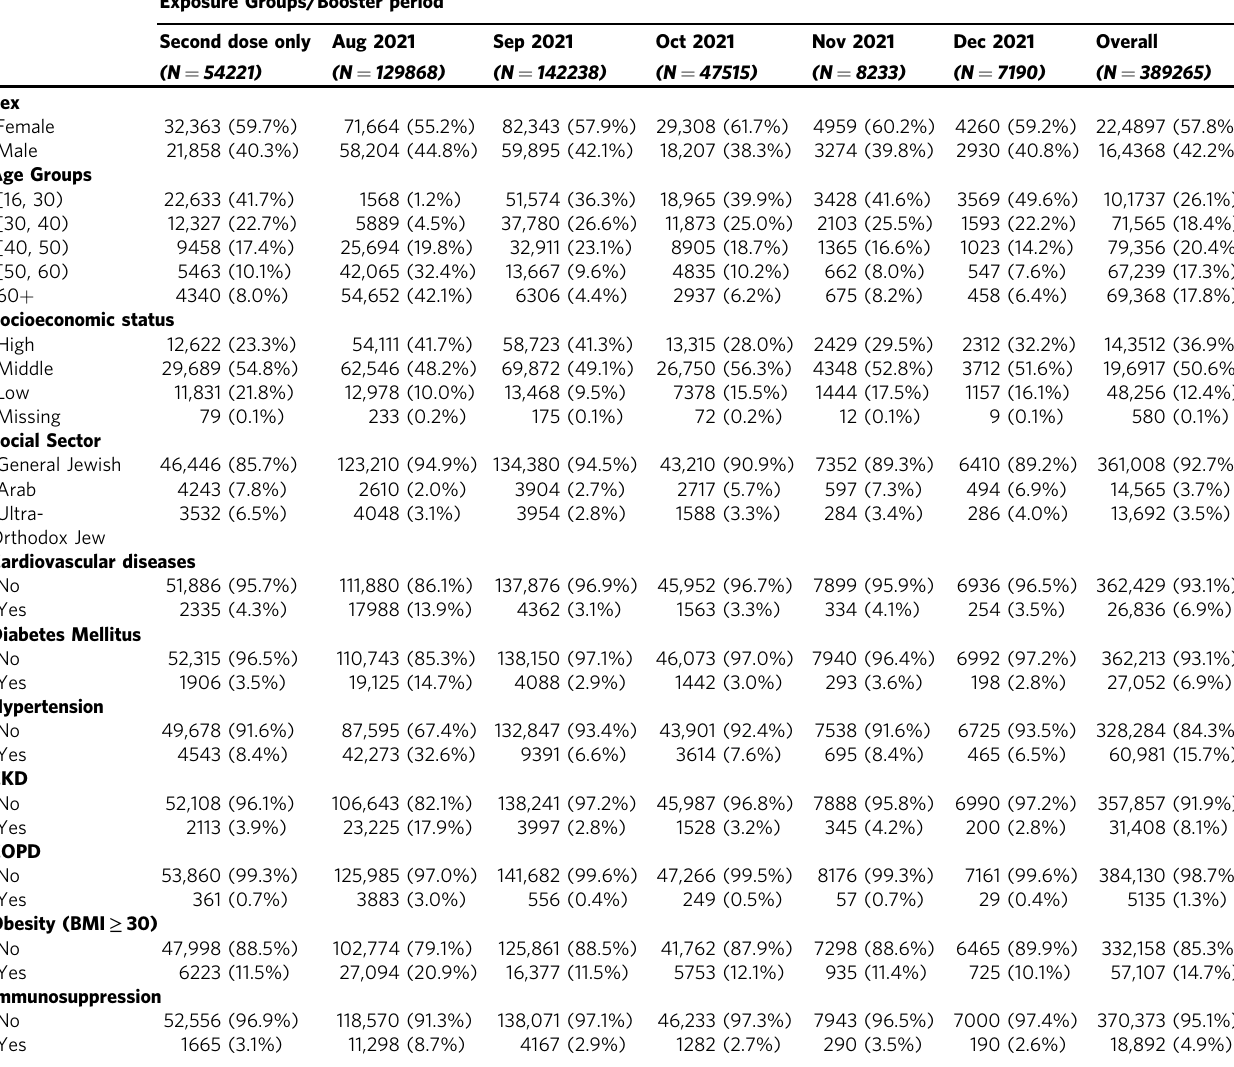
CKD Chronic Kidney Disease, COPD Chronic Obstructive Pulmonary